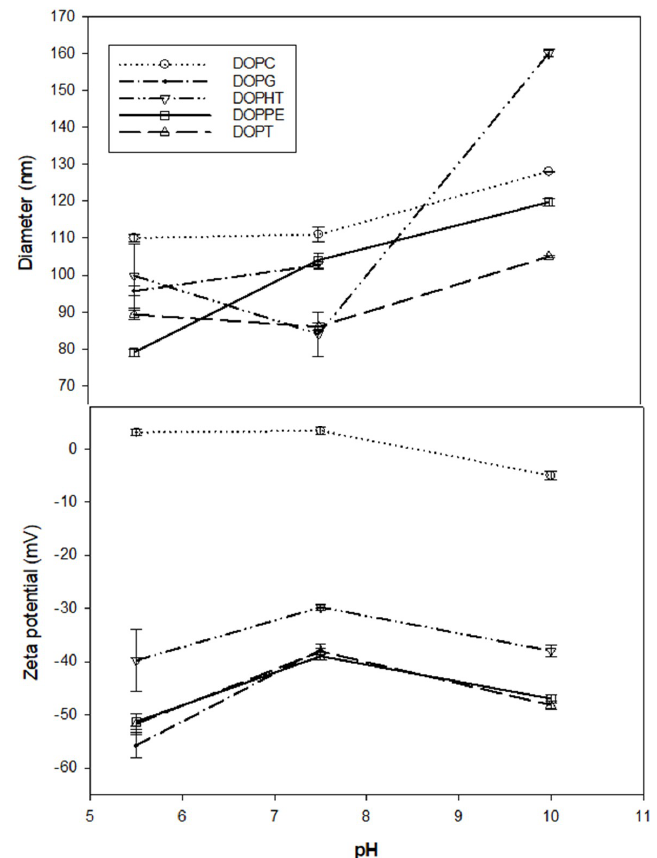
Figure 2. Liposome size ( top panel ) and zeta potential ( bottom panel ) as a function of buffer pH. 1,2-dioleoyl- sn -glycero phosphocholine (DOPC); 1,2-dioleoyl- sn -glycero-3-[phospho- rac -(1-glycerol)] (DOPG).